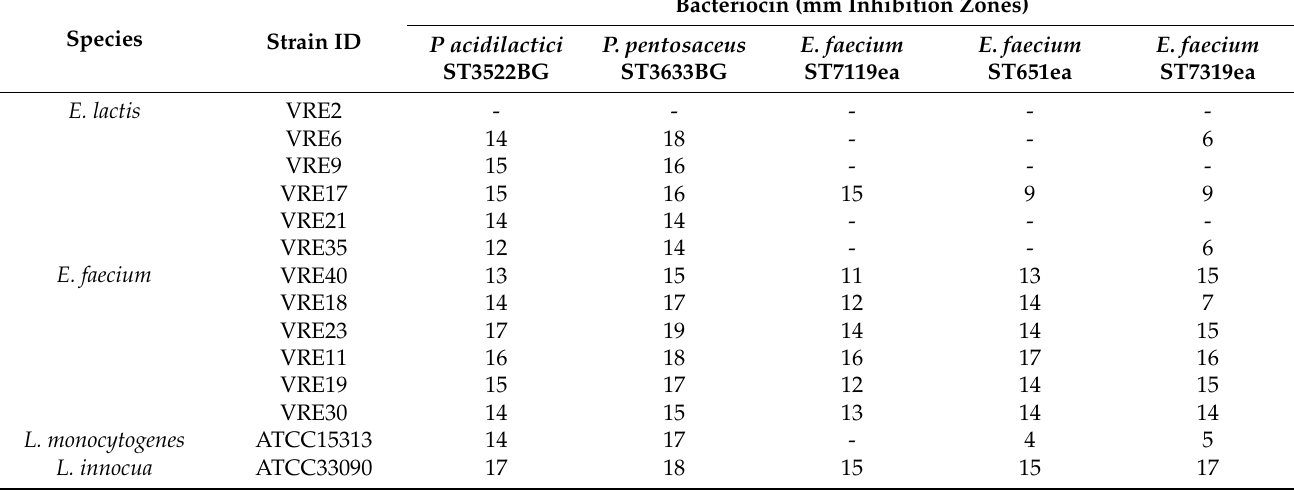
Table 1. Evaluation of bacteriocinogenic potential against clinical Enterococcus faecium VRE strains. The selected bacteriocin produced by P. acidilactici ST3522BG, P. pentosaceus ST3633BG, E. faecium ST7119ea, E. faecium ST651ea, and E. faecium ST7319ea were tested versus the investigated VRE strains. Growth inhibition was presented by measuring the inhibition zones, expressed in millimeters. (-): no growth inhibition. L. monocytogenes ATCC 15313 and L. innocua ATCC 33090 served as controls. Results are average values from three independent